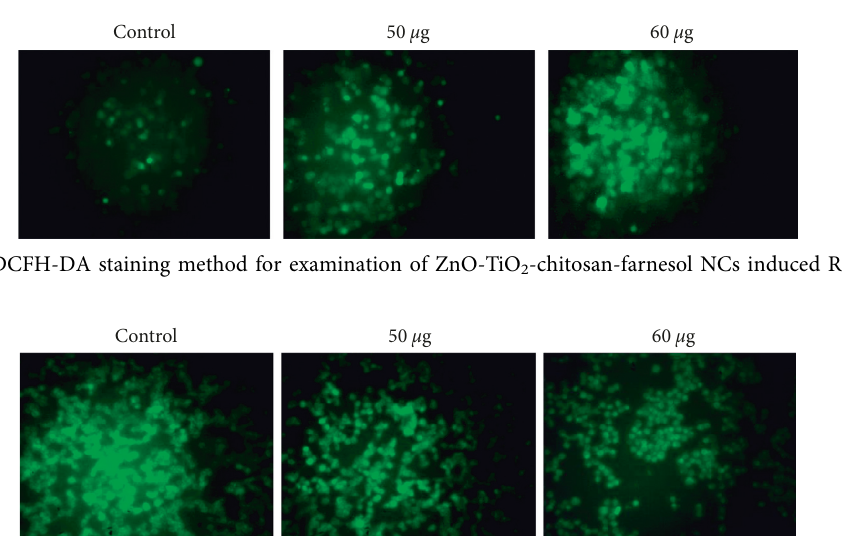
2 -chitosan-farnesol NCs.